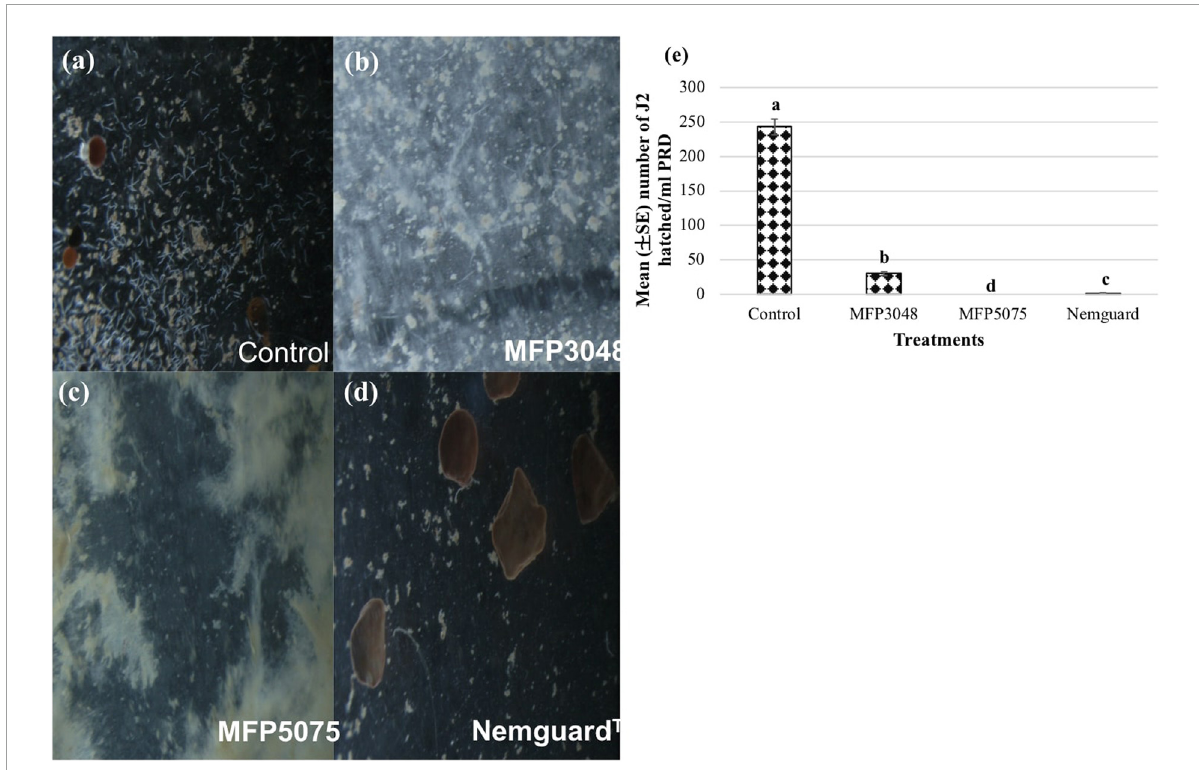
FIGURE4 Hatching of Globodera rostochiensis J2 observed at 8 × magnification in the treatments: (a) Untreated control; (b) MFP3048 treatment; (c) MFP5075 treatment; (d) Nemguard TM treatment; (e) Effect of products on the hatching of PCN J2 per ml of PRD. Values represented in graph by the same letters are not significantly different from each other ( p ≤